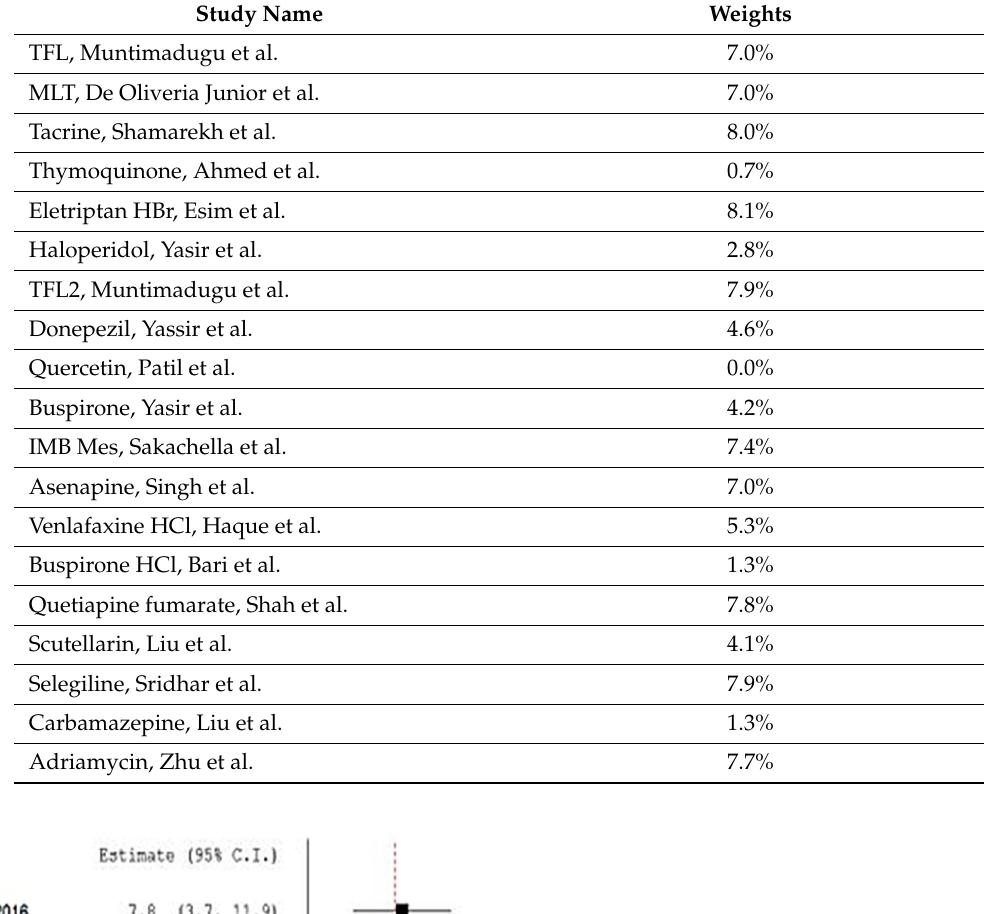
Table 2. Calculated weights of investigated studies.